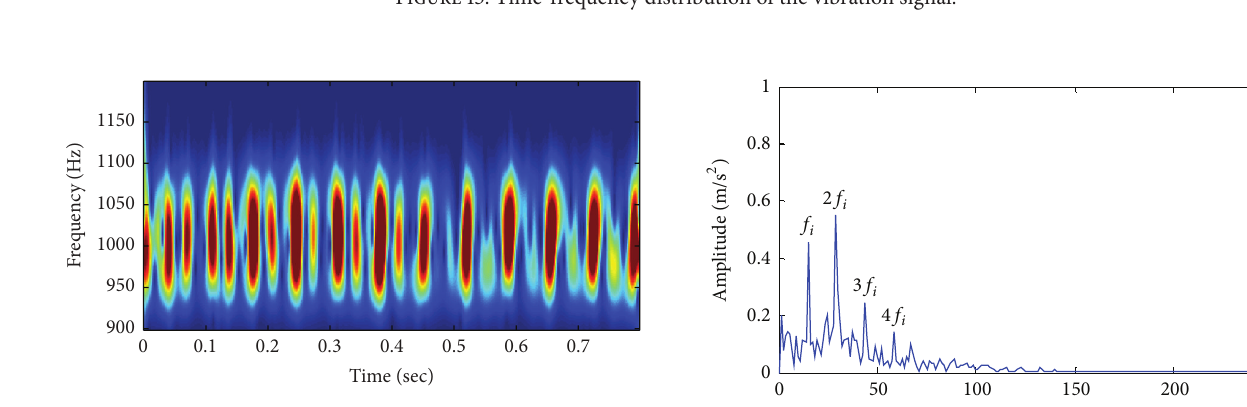
Figure 16: FSWT time-frequency distribution over the band 900– 1200 Hz.